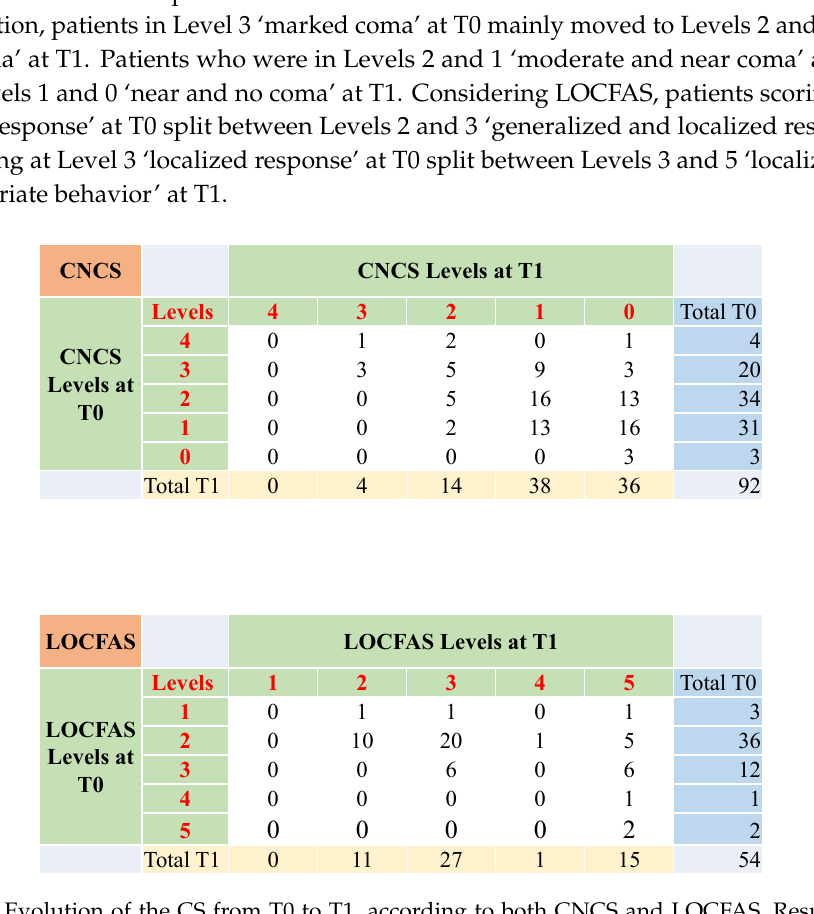
Figure 3. Evolution of the CS from T0 to T1, according to both CNCS and LOCFAS. Results refer to patients older than 48 months. The CNCS table shows that patients who were at Levels 2 and 1 ‘moderate and near coma’ at T0 chiefly moved to Levels 1 and 0 ‘near and no coma’ at T1. The LOCFAS table illustrates that patients scoring at Level 2 ‘generalized response’ at T0 split between Levels 2 and 3 ‘generalized and localized response’ at T1. Patients scoring at Level 3 ‘localized response’ at T0 split between Levels 3 and 5 ‘localized response and inappropriate behavior’ at T1.